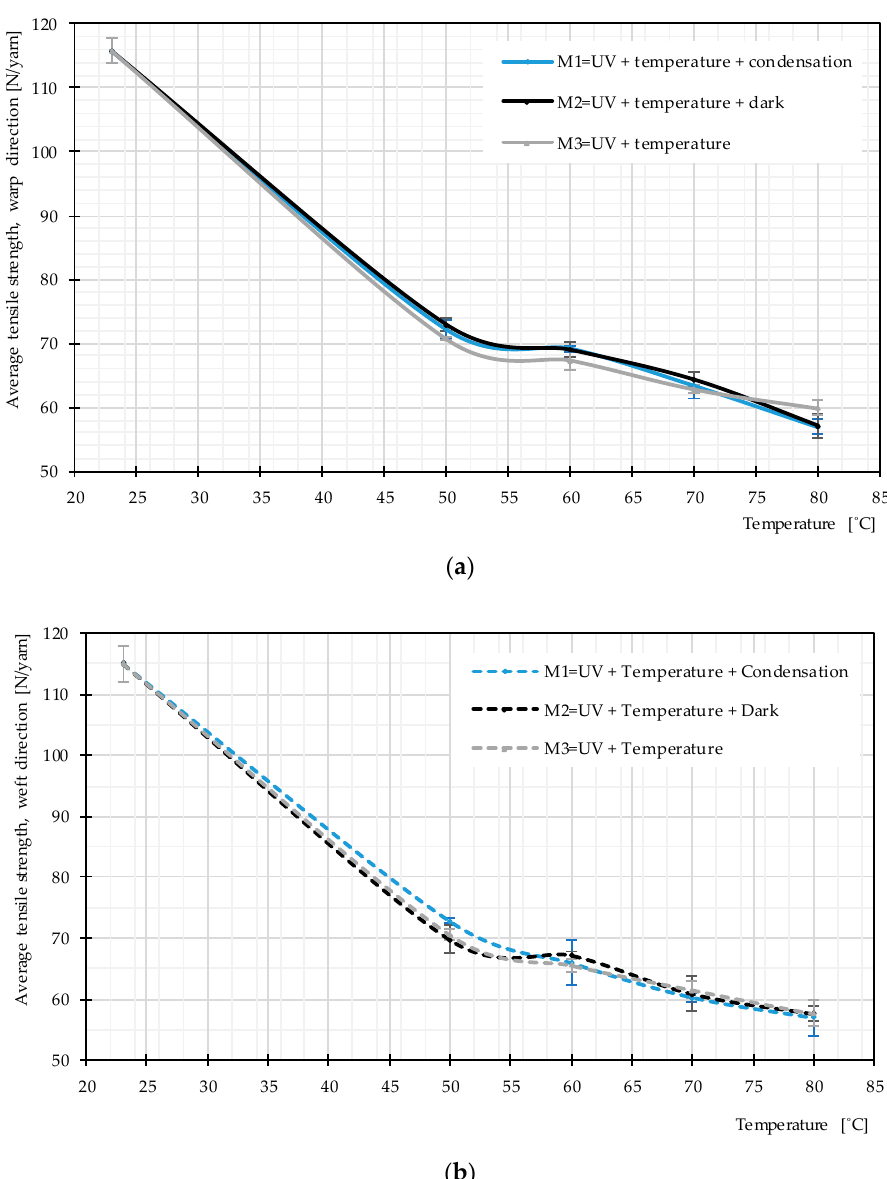
Figure 10. Average tensile strength, various weathering techniques at different temperature, uncoated PET Type III: ( a ) warp direction; and ( b ) weft direction.